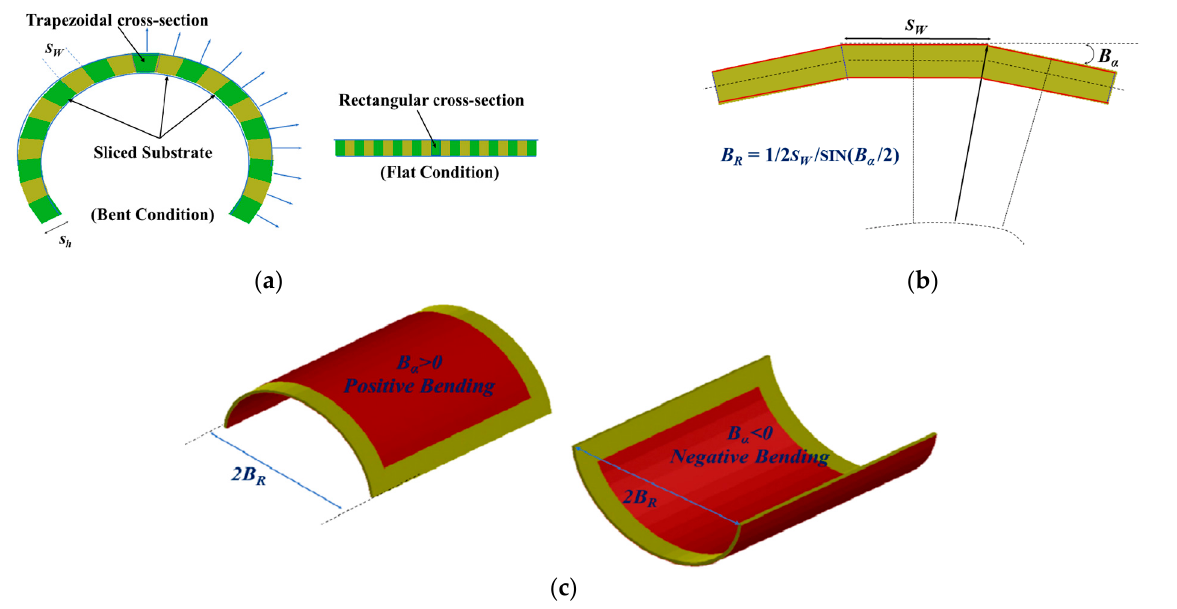
Figure 10. ( a ) Division of the flexible substrates into equal slices with a different cross sections in flat and bent conditions, ( b ) relation between bending angle and radius, and ( c ) orientation of bending with respect to the bending angle.